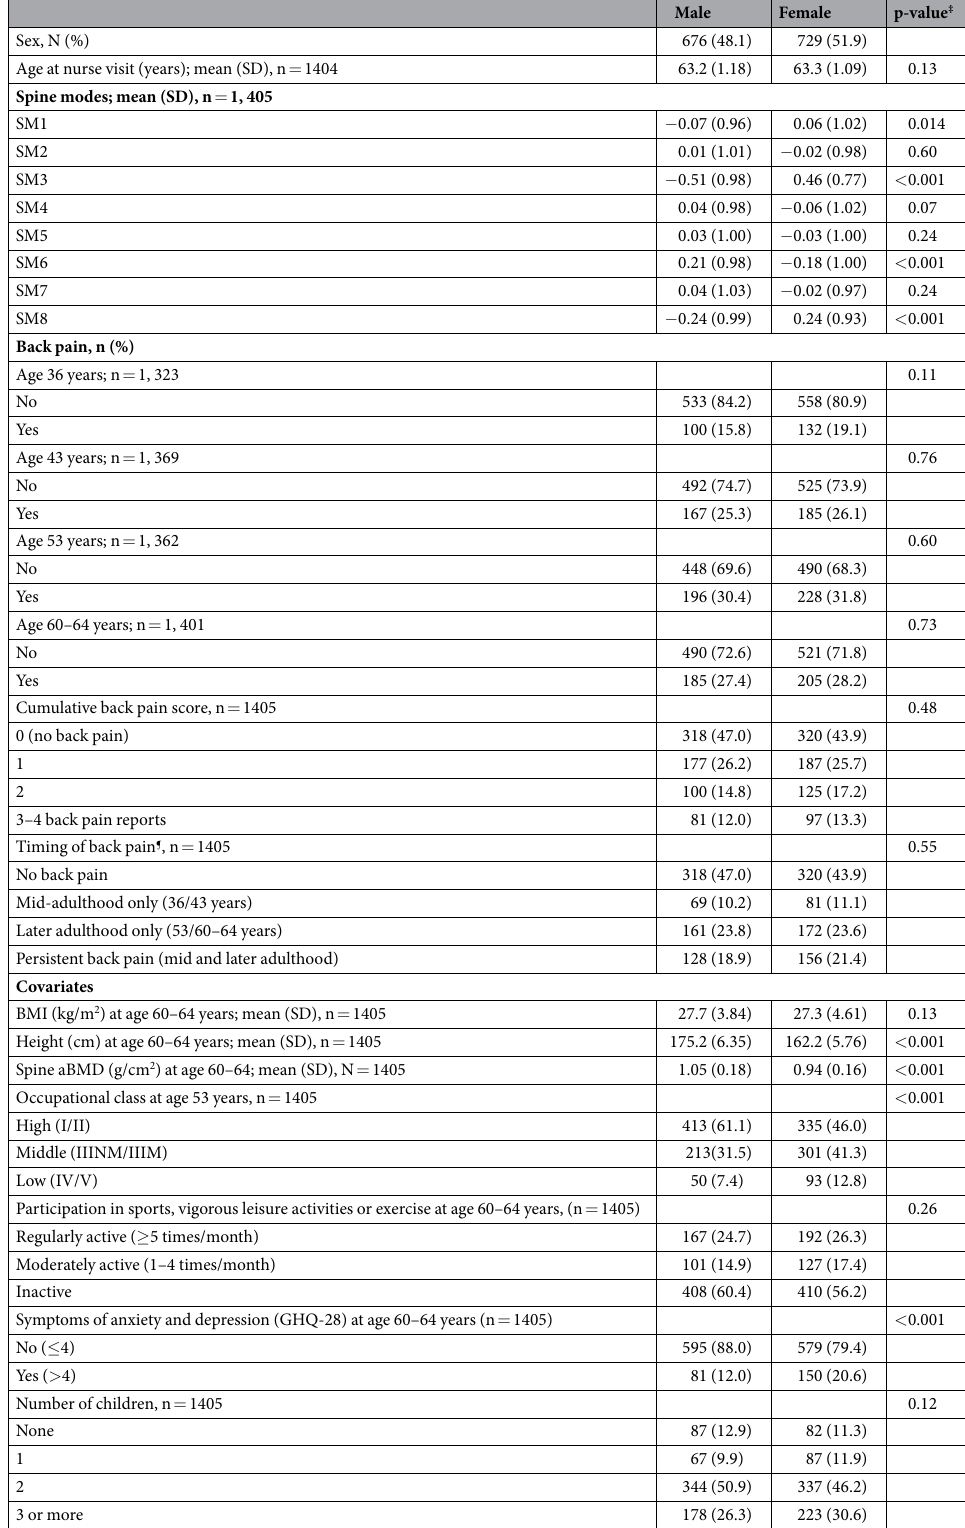
Table 2. Characteristics of the MRC National Survey of Health and Development study sample † at age